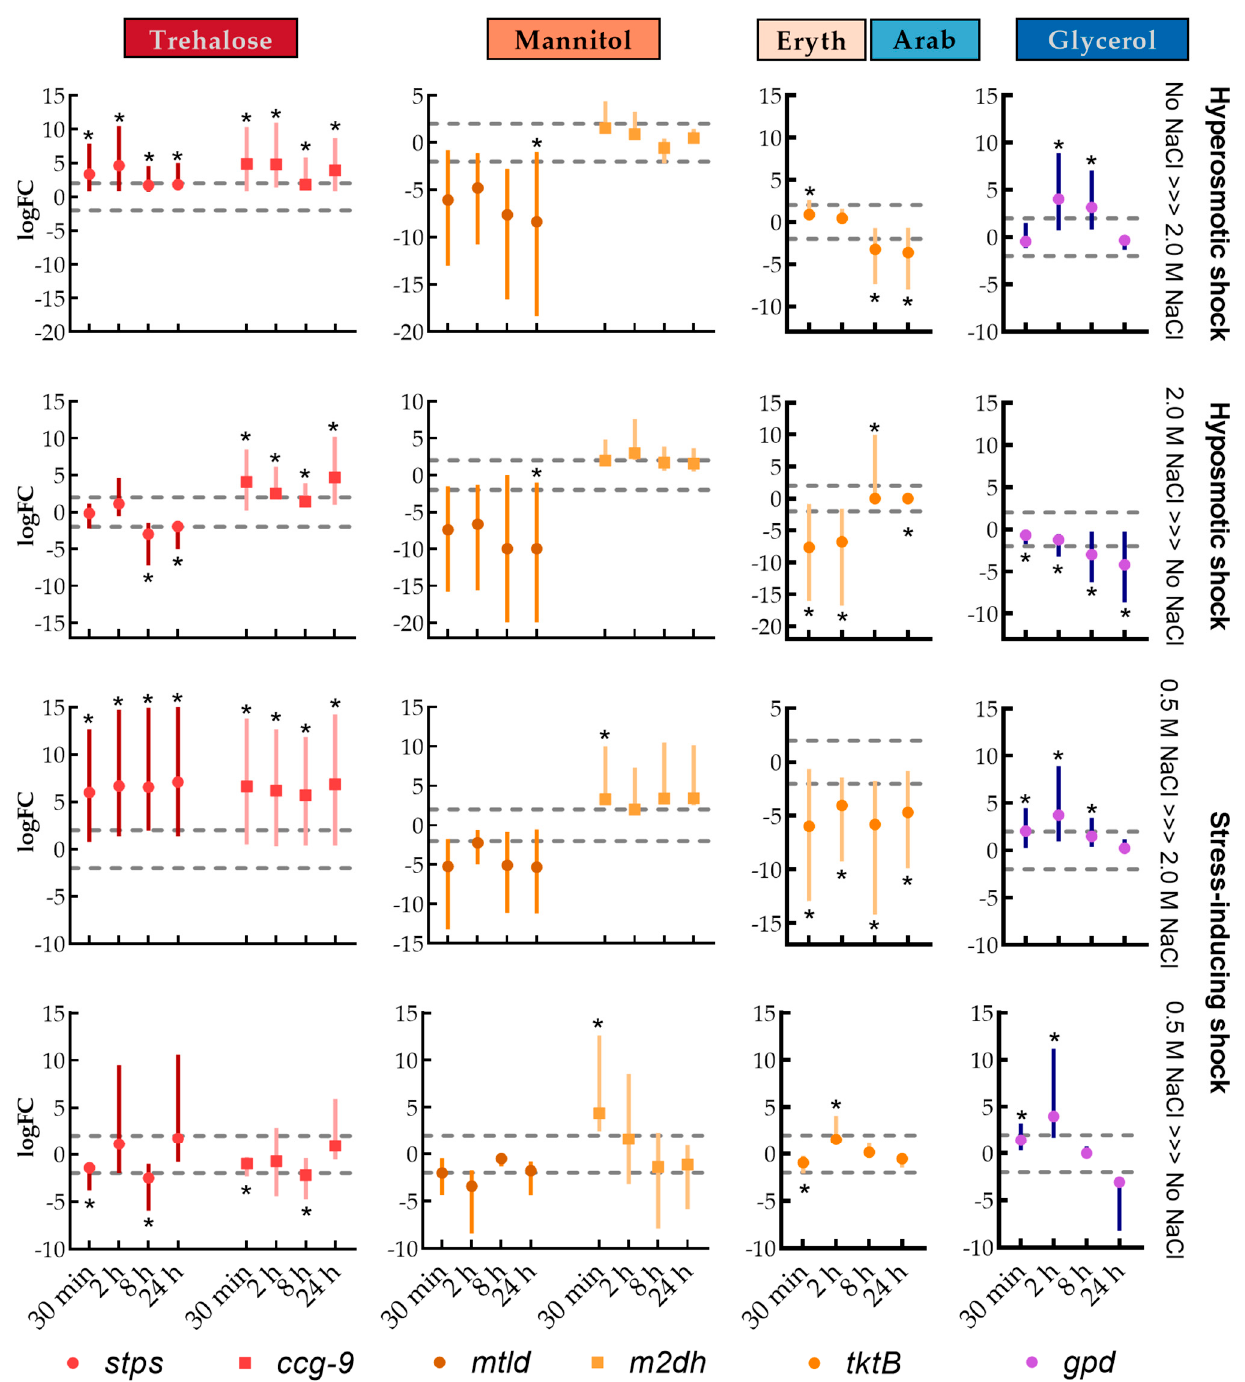
Figure 5. Transcriptional regulation of enzyme genes involved in the synthesis of osmolytes after hyperosmotic shock, hypoosmotic shock, and stress-inducing shock. The values correspond to the average and standard deviations of three biological replicates ( n = 3) and two technical qPCR replicates. The statistical significance (*) was assessed by a randomization test performed with the software Rest [46]. The dashed horizontal lines correspond to a cutoff logFC = ±2.